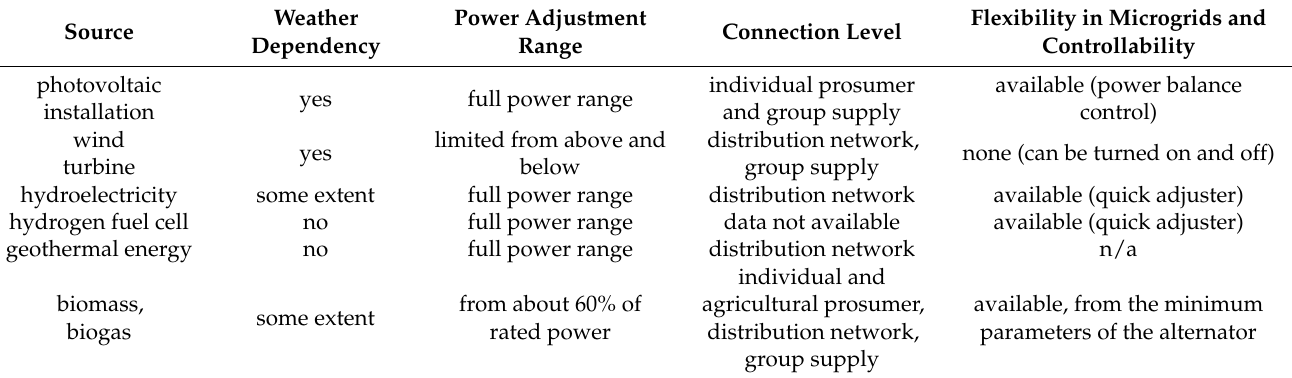
Table 1. Comparison of renewable energy sources in the context of electricity